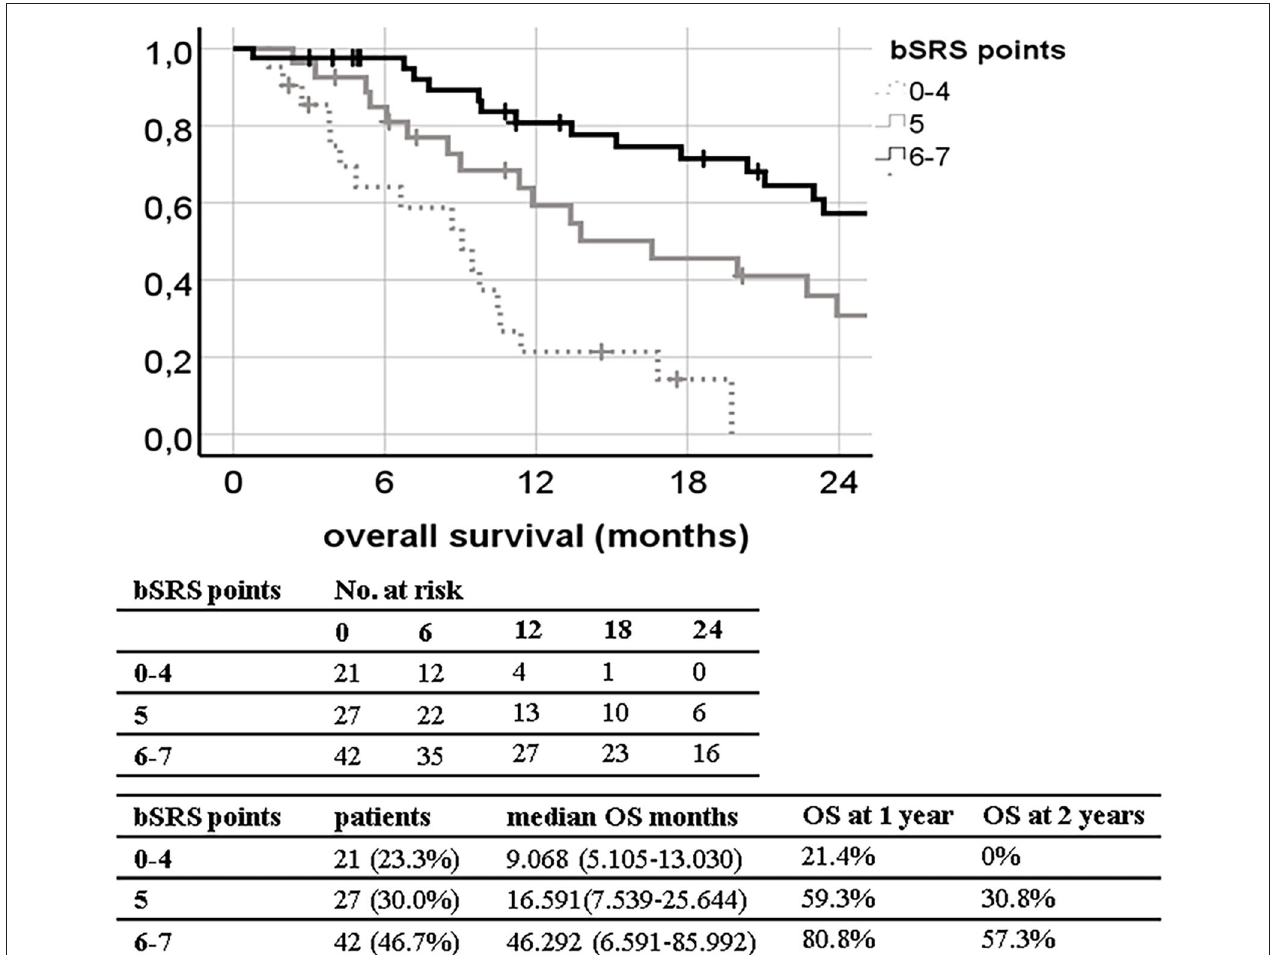
FIGURE 3 | Kaplan–Meier curves for overall survival (OS; n = 90) divided by the breast scoring tool for stereotactic therapy (bSRS) in our patient population (log-rank p < 0.001; concordance index 0.689; 95% CI, 0.577–0.802; p = 0.003) with 1- and 2-year OS